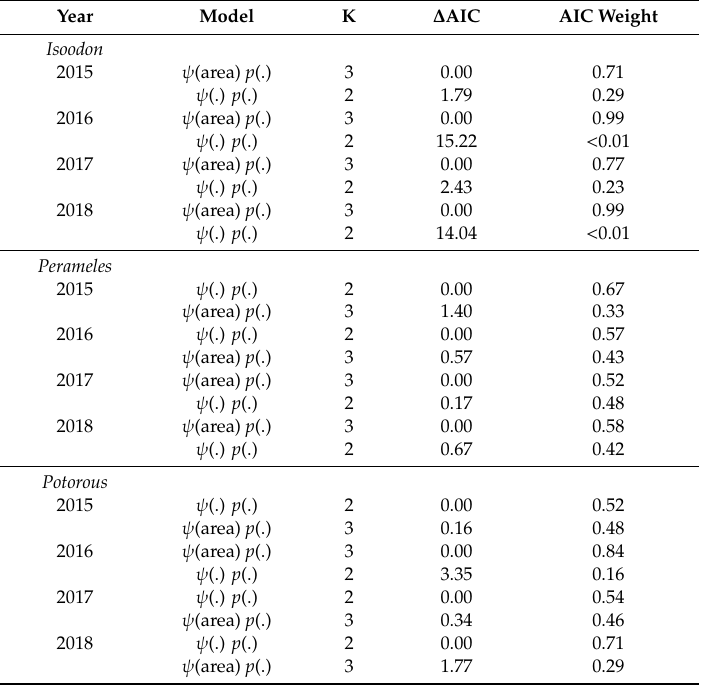
Table 4. Single-season occupancy model selection results for Isoodon , Perameles and Potorous between